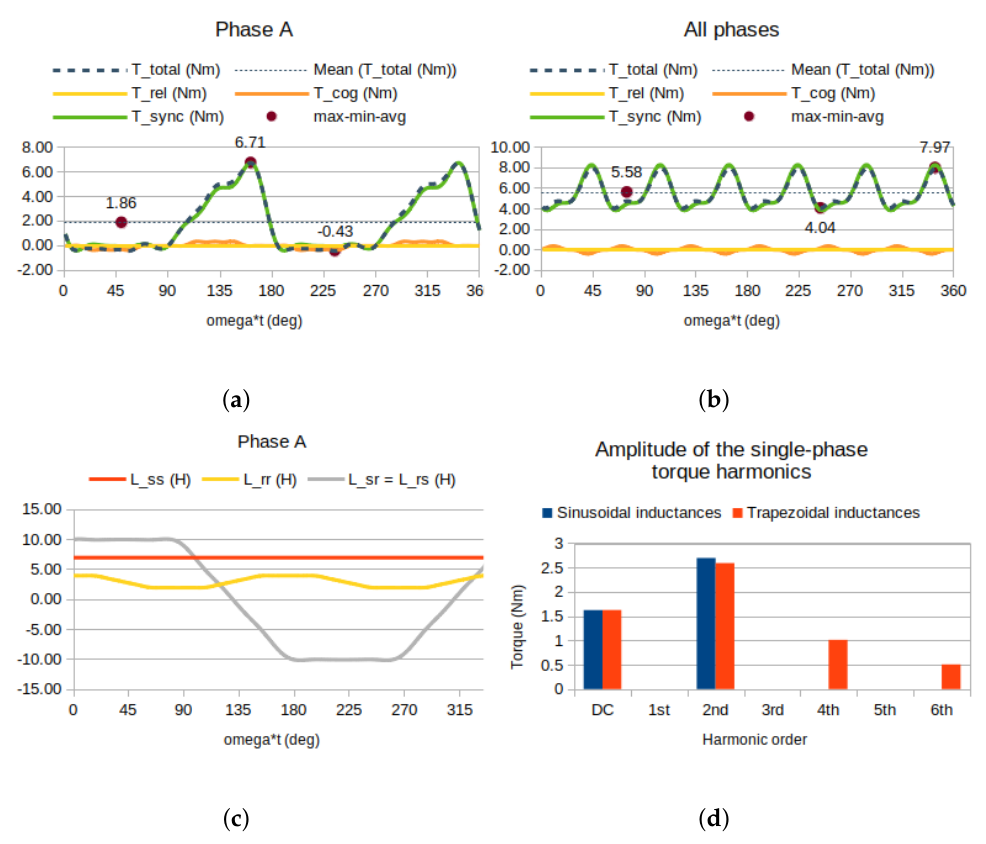
Figure 13. ( a ) Single-phase torque, assuming a sinusoidal variation of current and trapezoidal varia- tion of inductances, ( b ) three-phase torque, ( c ) inductances, and ( d ) single-phase torque harmonics comparison for sinusoidal and trapezoidal variation of